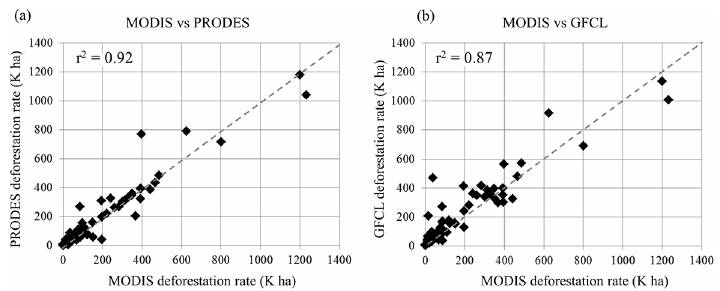
Fig 5. Comparing MODIS-derived annual deforestation rates with Landsat results in the Brazilian Amazon. (a) MODIS vs PRODES. (b) MODIS vs GFCL. A total of 70 data points are used in the scatter plot, which represent annual estimates between 2000 and 2010 in seven Brazilian states in the legal Amazon, including Acre, Amapa, Amazonas, Mato Grosso, Para, Rondonia and Roraima.